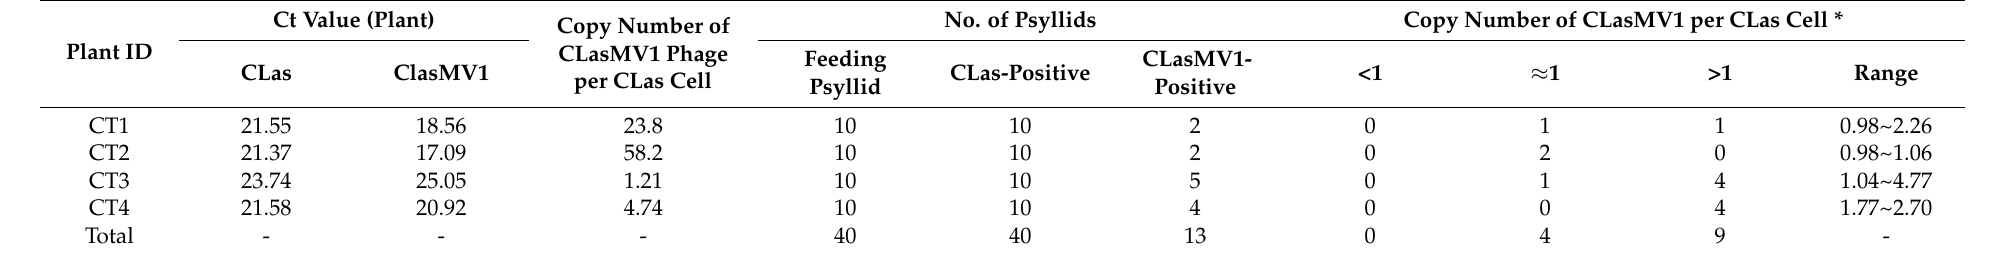
Table 1. Quantification result of “ Candidatus Liberibacter asiaticus” and CLasMV1 phage in infected citrus hosts and Asian citrus psyllid